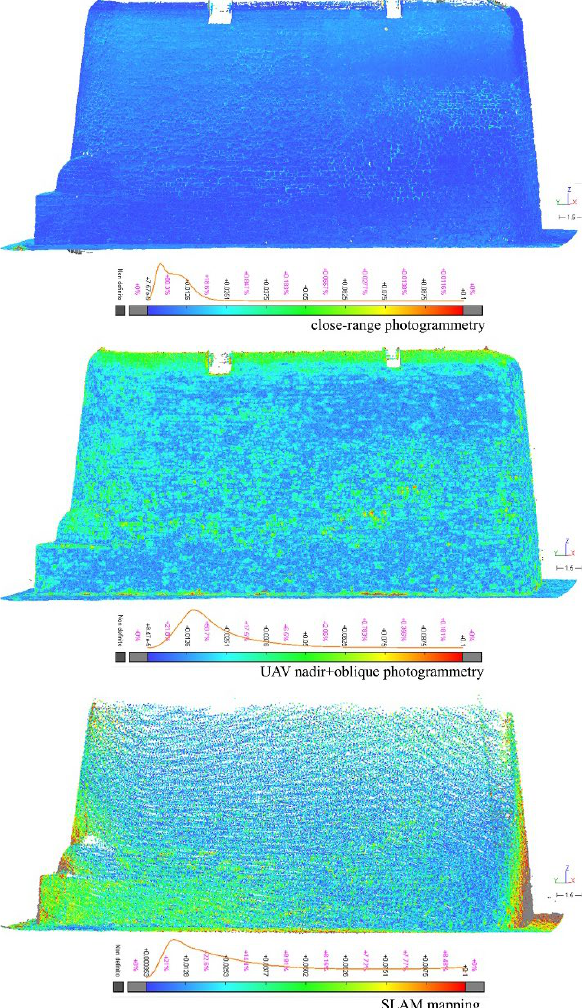
Figure 10. Deviation maps for point clouds comparison. Lidar as ground